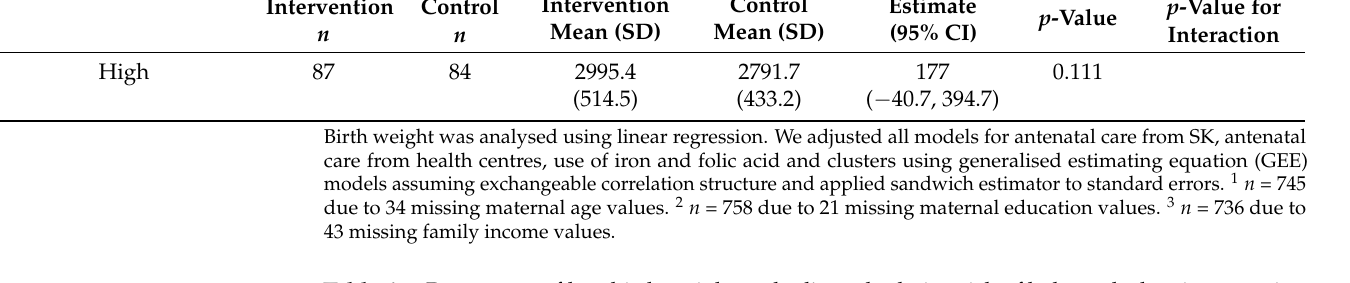
Table A2. Percentage of low birth weight and adjusted relative risk of balanced-plate intervention compared to usual